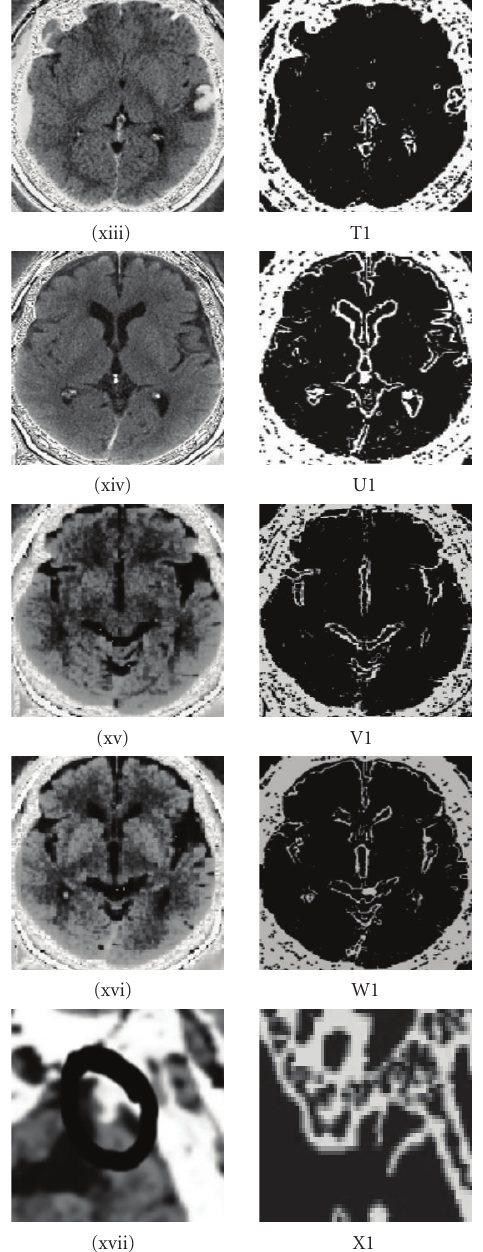
Figure 8: (T1) contour extraction of subdural haematoma and nonhemorrhagic contusion (xiii), (U1) contour extraction of subdural hygroma (xiv), slice 17, (V1) contour extraction of sub- dural hygroma (xv), slice 15, (W1)contour extraction of subdural hygroma (xvi), slice 16, (X1) contour extraction applied to brain atropy on left frontal lobe (xvii).